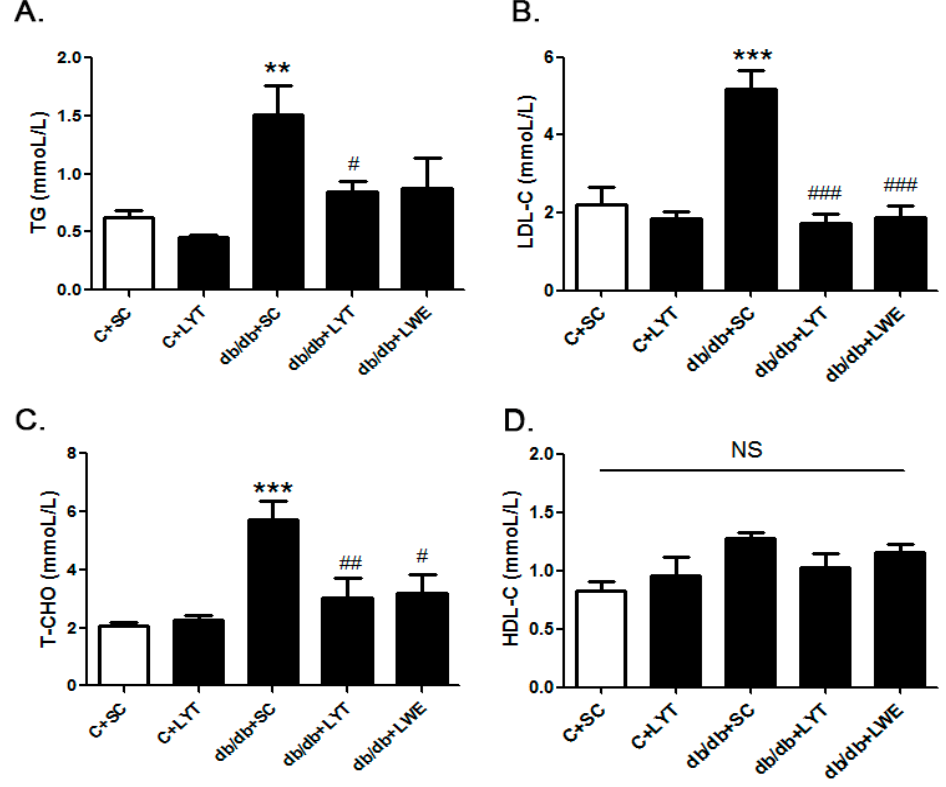
Figure 2. Serum lipid profile of six groups of mice at 20 weeks old. Triglyceride ( A ); low-density lipoprotein cholesterol ( B ); total cholesterol ( C ); and high-density lipoprotein cholesterol ( D ). Values are means ± SE ( n = 4–6). ** p < 0.01; *** p < 0.001 compared with C + SC group; # p < 0.05; ## p < 0.01; ### p < 0.001 when compared with the db/db + SC group; NS, no significant difference.